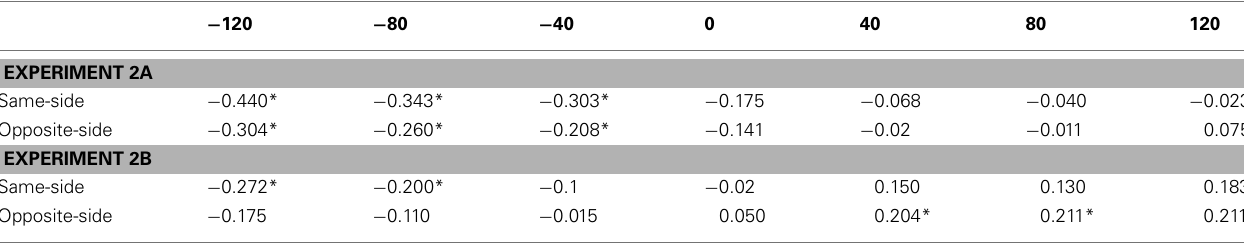
Table 2 | Perceived offset position in Experiment 2 in visual